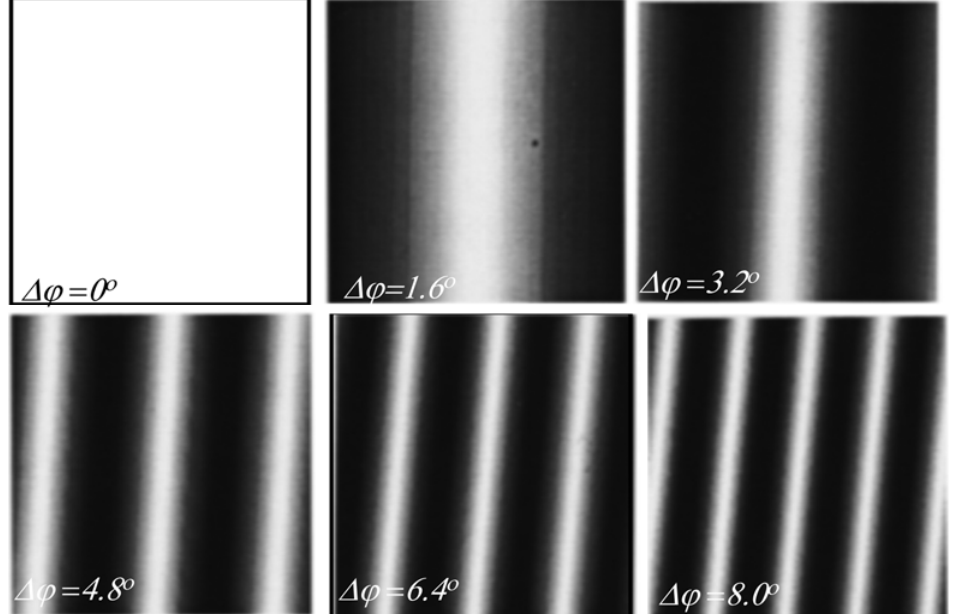
Figure 3. Interference fringes of tilt simulated in an RSI when the shear angle is increased from 0° ‐ rotation angle (blank field) to 8° in increments of 1.6° (axis of rotation is normal to the page). The shear angle is the angle of the orientation of the Dove prism, or the wavefront rotator in Figure 2. The density of fringes increases, and the fringe inclination angle decreases with increasing wavefront rotation angle. The fringe angle is defined as the angle that the straight line through the bright fringe makes with the horizontal axis.